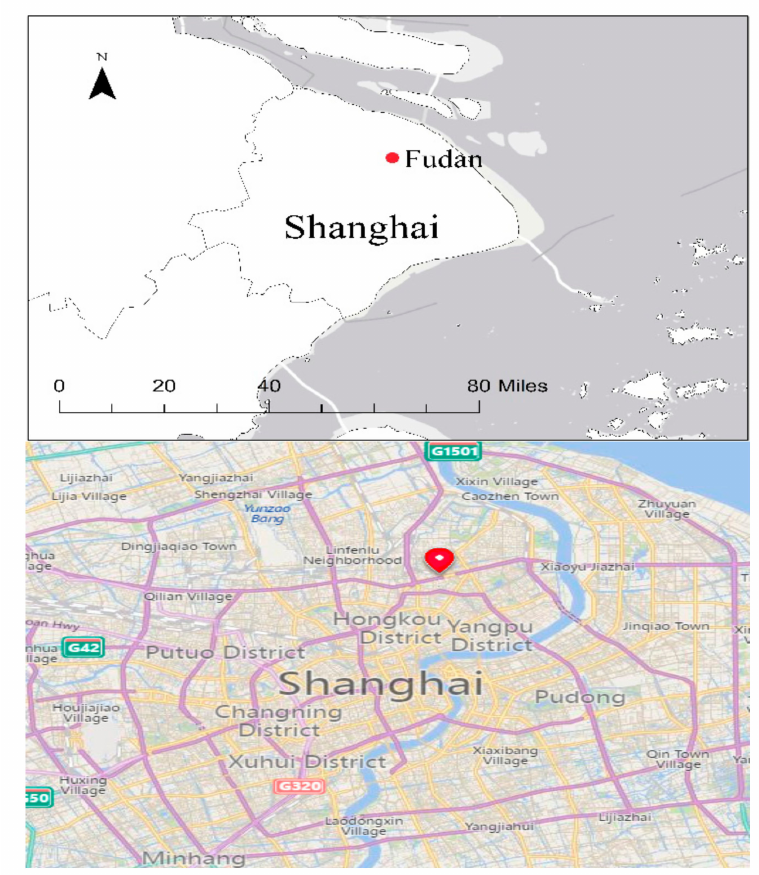
Figure 1. The location of the MAX-DOAS instrument. The measured scattered light spectra are analyzed using QDOAS software (Danckaert T, Fayt C, Van Roozendael M, De Smedt I, Letocart V, Merlaud A, Pinardi G.; Version 2.109; Royal Belgian Institute for Space Aeronomy (BIRA-IASB);Uccle, Belgium; 9 April 2015) to retrieve the differential slant column density (DSCD). The concentration of a given absorber integrated along the effective light path is relative to the amount of the same absorber in a measured reference spectrum (DSCD = SCD-SCDref) of O 4 , NO 2 , and HCHO. In order to remove the Fraunhofer lines in the solar spectrum, the reference spectrum chose the measured spectrum at solar zenith angle (SZA) = 13.2 ◦ at 12:00 LT (local time, LT = UTC + 8 h) on 4 August 2015. The following O 4 , NO2, HCHO DSCDs were determined by a DOAS fit in the wavelength range 337~370 nm, 411~435 nm, and 336~359 nm, respectively. Table 1 gives cross-sections used in DOAS fitting, and the absorption structure of Ring effect is calculated using QDOAS software in advance. In this paper, we only considered the data with high signal noise ratio (SNR), which refers to the DSCD data whose ratio of the obtained DSCD deviation by inversion to the DSCD is less than 0.2. Only data with root mean square (RMS) less than 1 × 10 − 4 were used. Based on the above criteria, 10% of the original data were